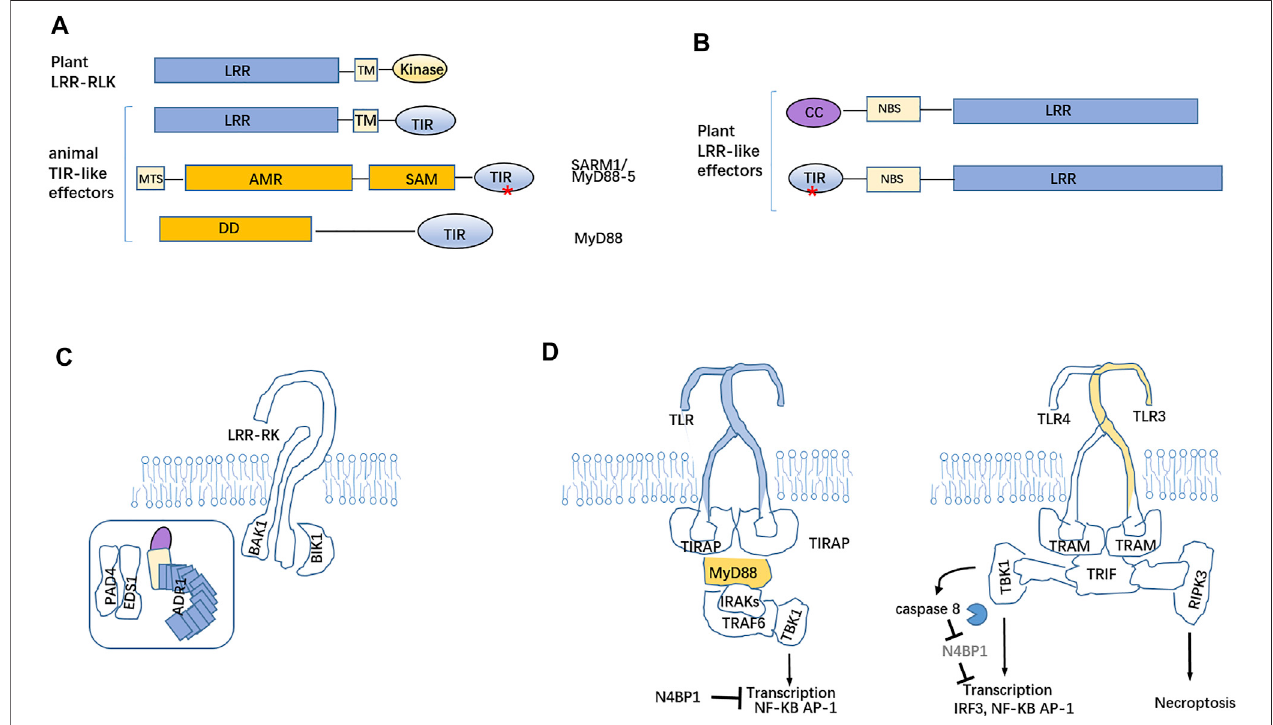
FIGURE 3 | Mutual potentiation and regulation of TLR-mediated immunity and NLR-mediated immunity in plants and animals. (A) LRR-RLK (receptor-like kinase) confer to pattern-triggered immunity, functionally similar to animal Toll-like on the cell surface. SARM1 has a mitochondria-targeting signal (MTS), AMR, SAM, and C-terminal TIR domain, where there being conserved Asp/Glu residues, which endow the NADase activity. (B) Cytosolic CNL and TNL are composed of NBS and LRR domains with a distinct N -terminal region (coiled coil or TIR domain). (C) The PAD4-EDS1 complex and ADR1 together locate the inner lea fl et of the plasma membraneandenhancePRR(LRR-RK)-and RLCK (BIK1)-dependentPTI. (D) Cytosolictollandinterleukin1receptor (TIR) ofTLR4caninterplay withtheTIRdomain(s) of four adaptor molecules MyD88, TIRAP, TRIF, and TRAM to transmit the cascade reaction and promote the secretion of in fl ammatory factors and interferons. The capase-8 substrate, N4BP, act as a suppressor of cytokine responses. Asterisk (*) represents the catalytic activities of TIR domains.